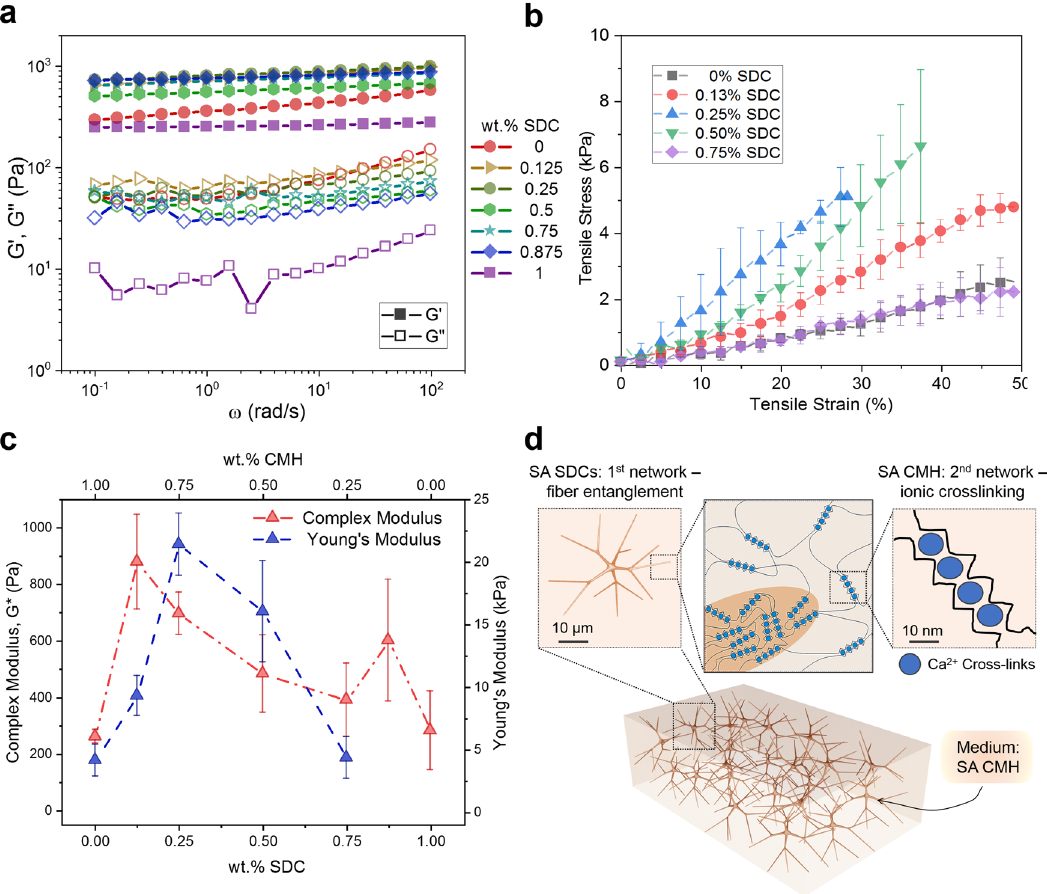
Fig. 3 Mechanical properties of SA homocomposite gels. a Frequency sweeps of 1.0 wt.% HHGs of varying SDC concentrations (typical curves with data consistency within 10%). b Representative stress – strain curves for various HHGs ( n = 5). c Rheological complex modulus obtained from a frequency sweeps at a frequency of 1 rad/s (red, n = 3) and tensile (blue, n = 5) properties of various SDC/CMH HHGs. Total alginate concentration is maintained at 1.0 wt.% for all data. d Schematic of the hierarchical interactions between the colloidal and molecular alginate networks in HHGs. These results demonstrate the structural synergism of the double SDC and CMH networks within HHGs resulting in controllable and self-reinforced high composite